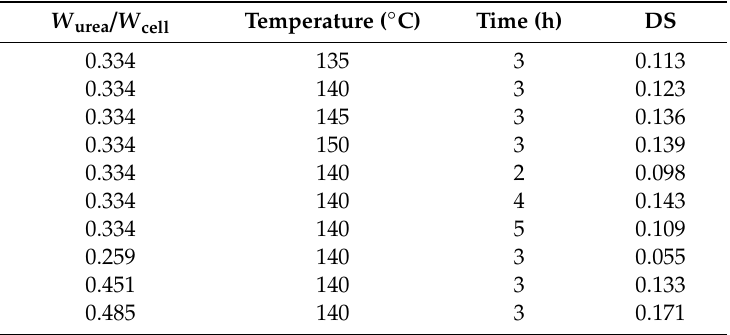
Table 1. Conditions and results of cellulose carbamate (CC)